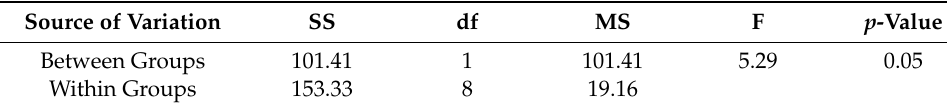
Table 5. ANOVA analysis for the flexural strength.